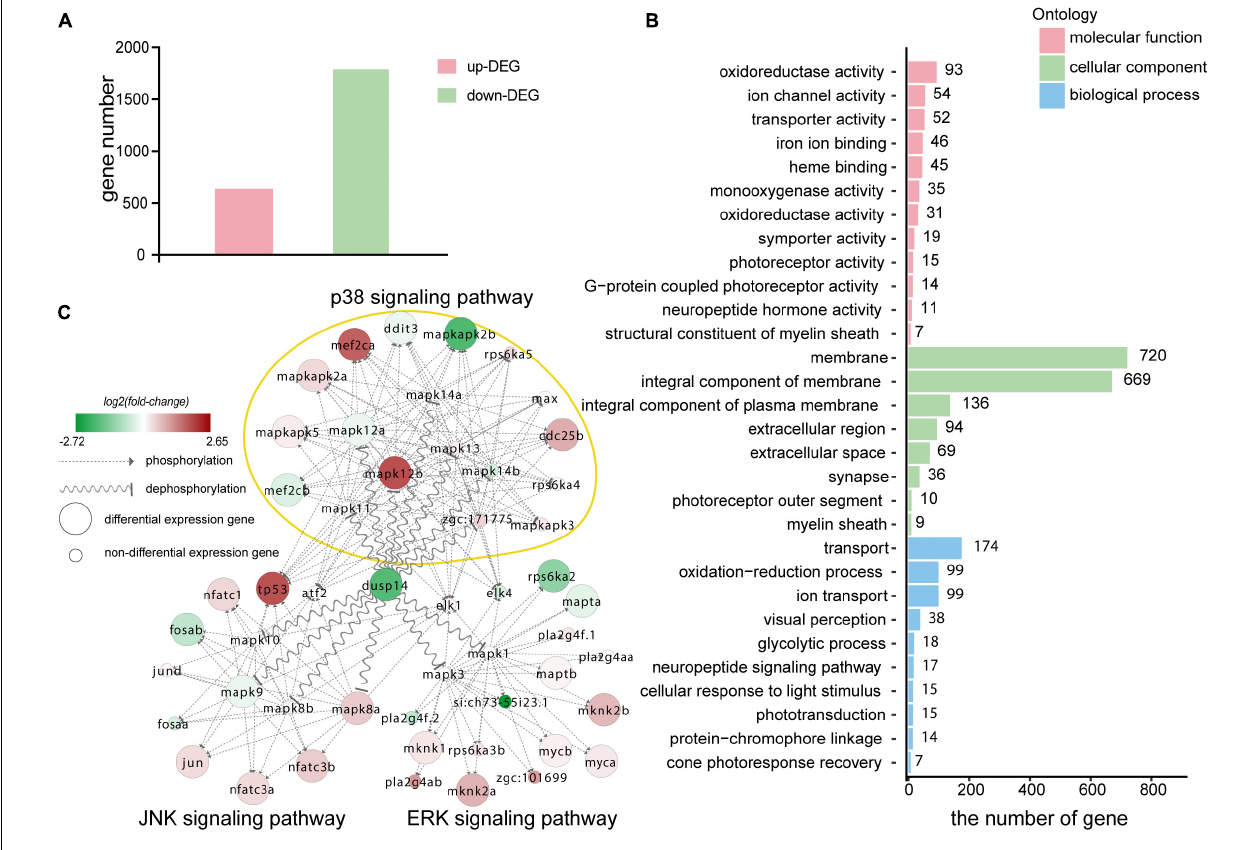
Frontiers in Cellular Neuroscience |